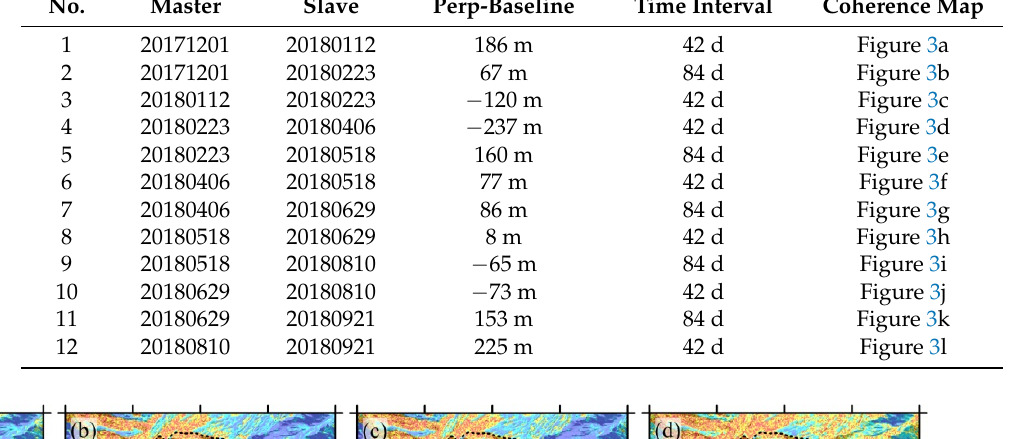
Table 1. The details of the selected InSAR pairs.